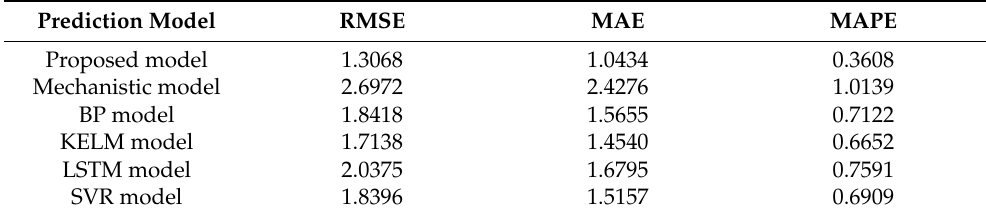
Table 3. Comparison of prediction performance indicators for different prediction models when the data fluctuate